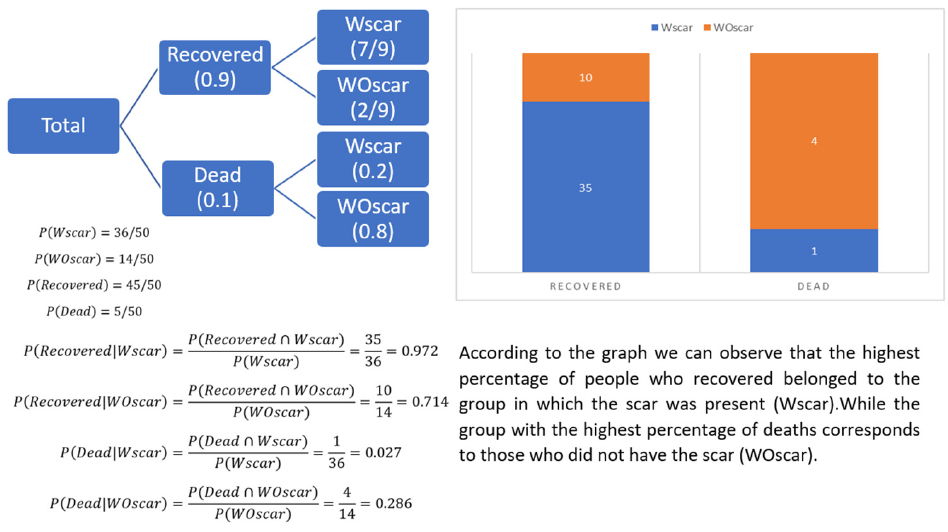
Figure 8. The practice of Team 4 of prospective teachers (G1) on Activity